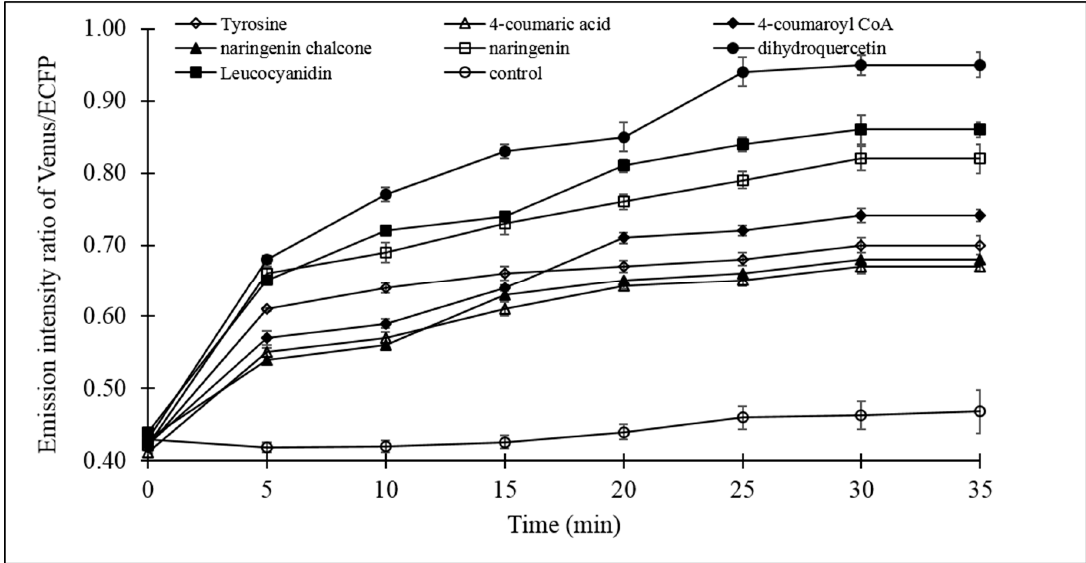
Figure 6. Live cell dynamics of ( + )-catechin biosynthesis in bacterial cell. Catechin biosynthesis was measured on the basis of the emission intensity ratio of Venus / ECFP (FRET ratio). Values are mean of three independent replicates. Vertical bars show standard error.